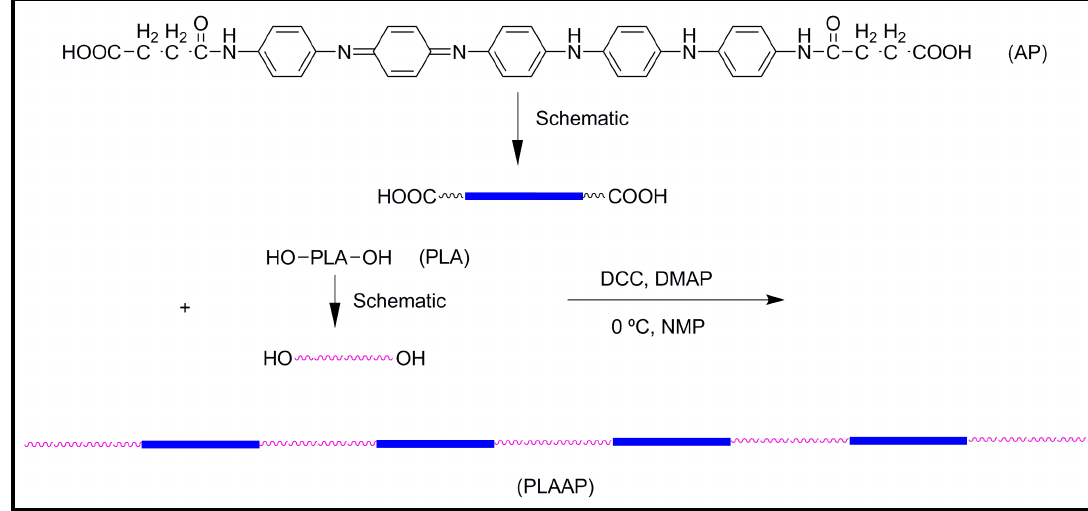
Figure 12. Schematic synthesis route and structure of PLA- co -AP copolymer.